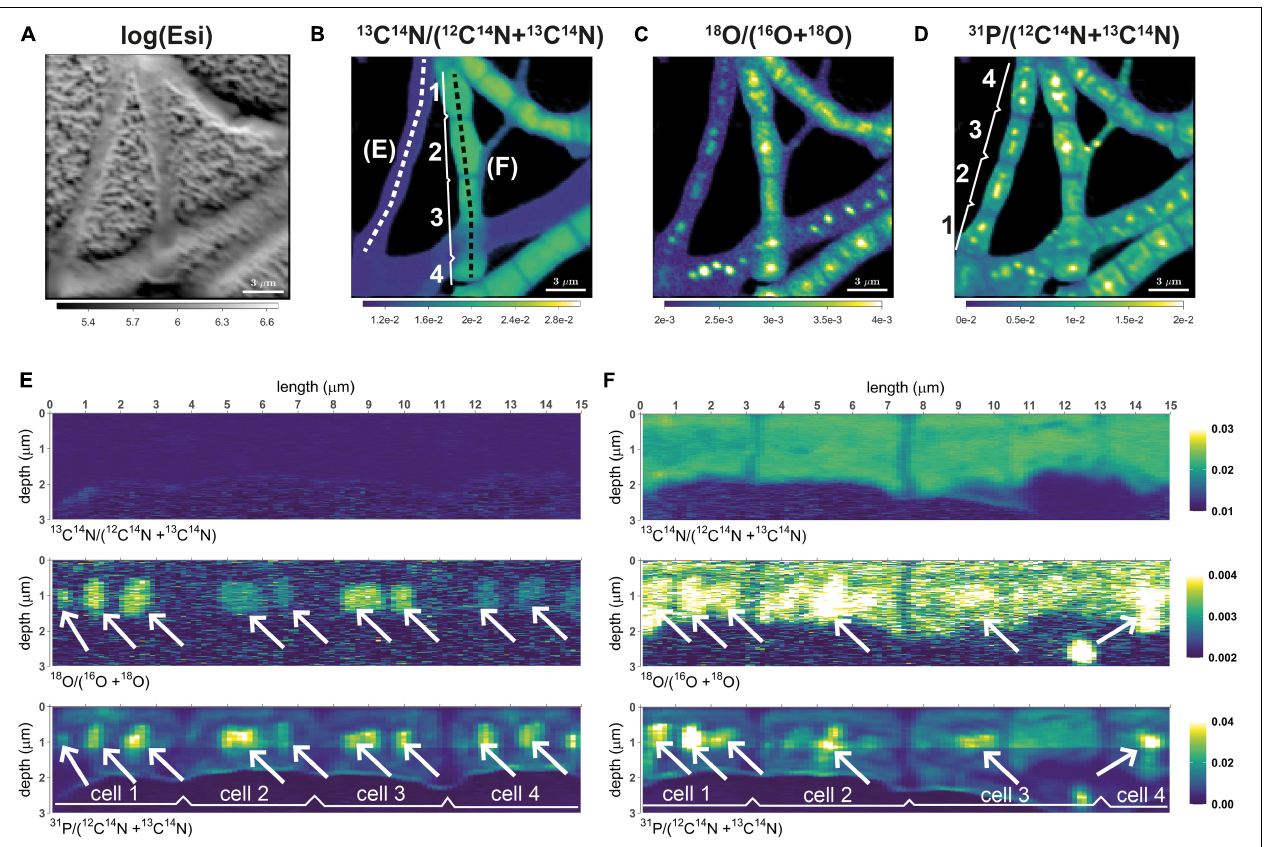
FIGURE 1 | Distributions of 13 C and 18 O labeling in cable bacteria. Shown are representative data for filament segments retrieved from the suboxic zone after 6 h of incubation. (A) Intensity of secondary electrons (log-transformed). (B) 13 C atom fraction, calculated as 13 C 14 N/( 12 C 14 N + 13 C 14 N). (C) 18 O atom fraction, calculated as 18 O/( 16 O + 18 O). (D) Relative phosphorus content, approximated as 31 P/( 12 C 14 N + 13 C 14 N). (E,F) Depth profiles of the 13 C atom fraction, 18 O atom fraction, and the relative phosphorus content along profiles spanning across four cells from two filaments. Profiles correspond to filaments that showed no (panel E ) and some of the highest (panel F ) carbon assimilation during the incubation. The corresponding profile locations are shown by the white and black dotted lines in panel (B) . White arrows point toward selected polyphosphate granules present in the cells. Color scales for panels (E,F) are the same. Scale bar is 3 µ